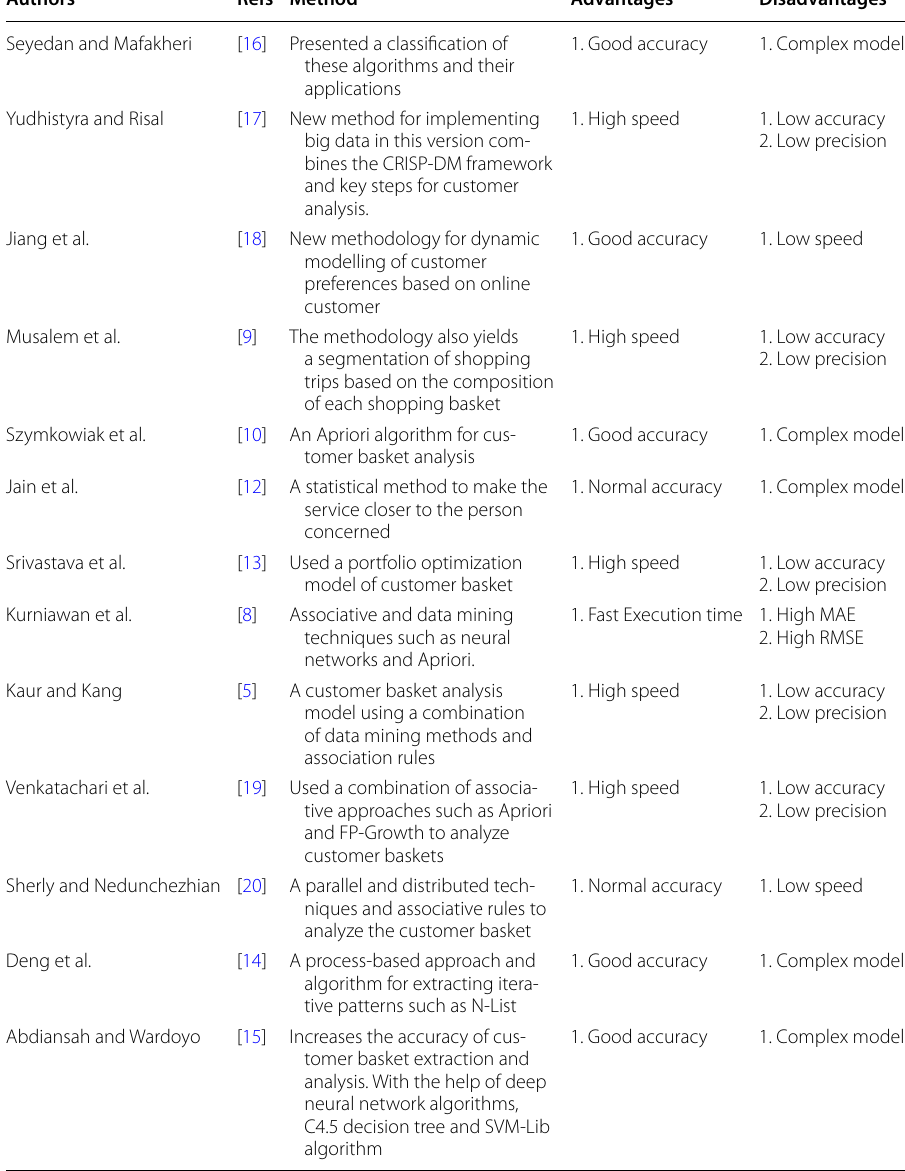
Table 1 Comparison of the most important the advantages and disadvantages of the reviewed previous methods to an analytics model for customers’